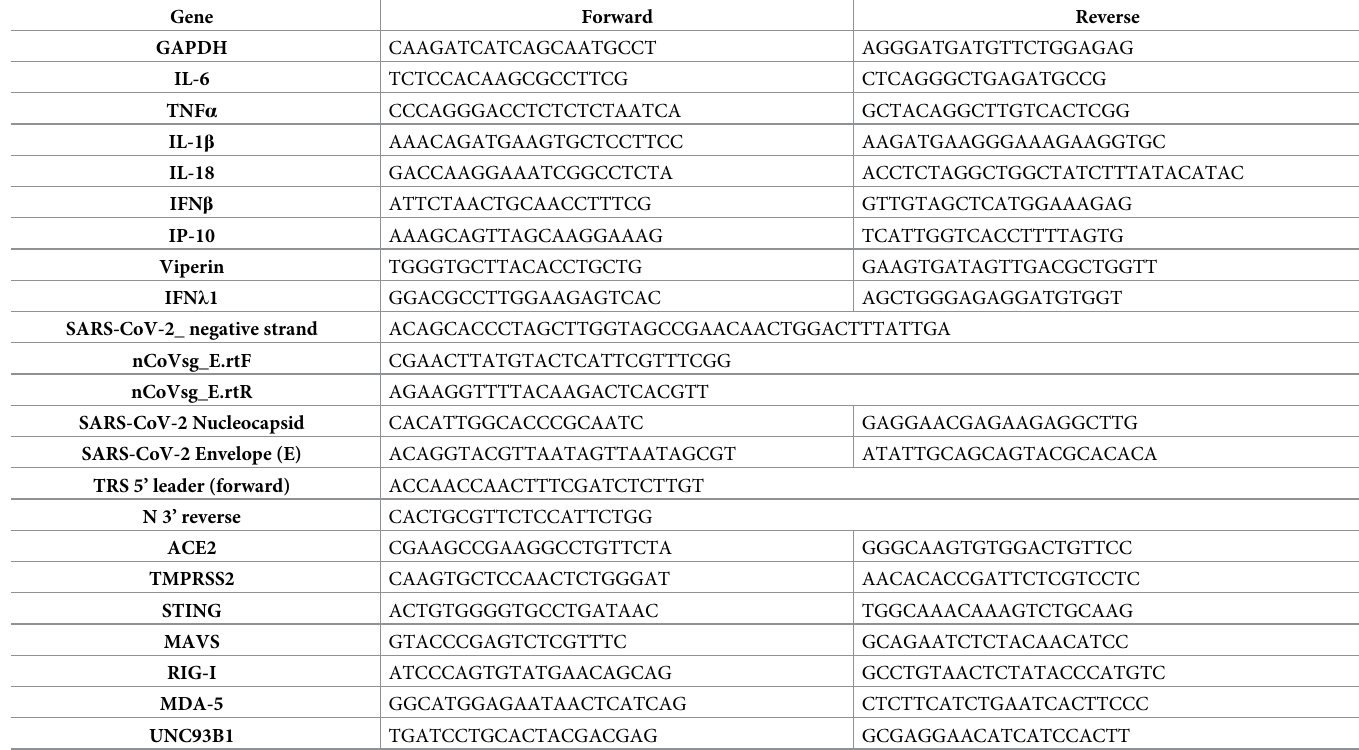
Table 1. qRT-PCR primers.